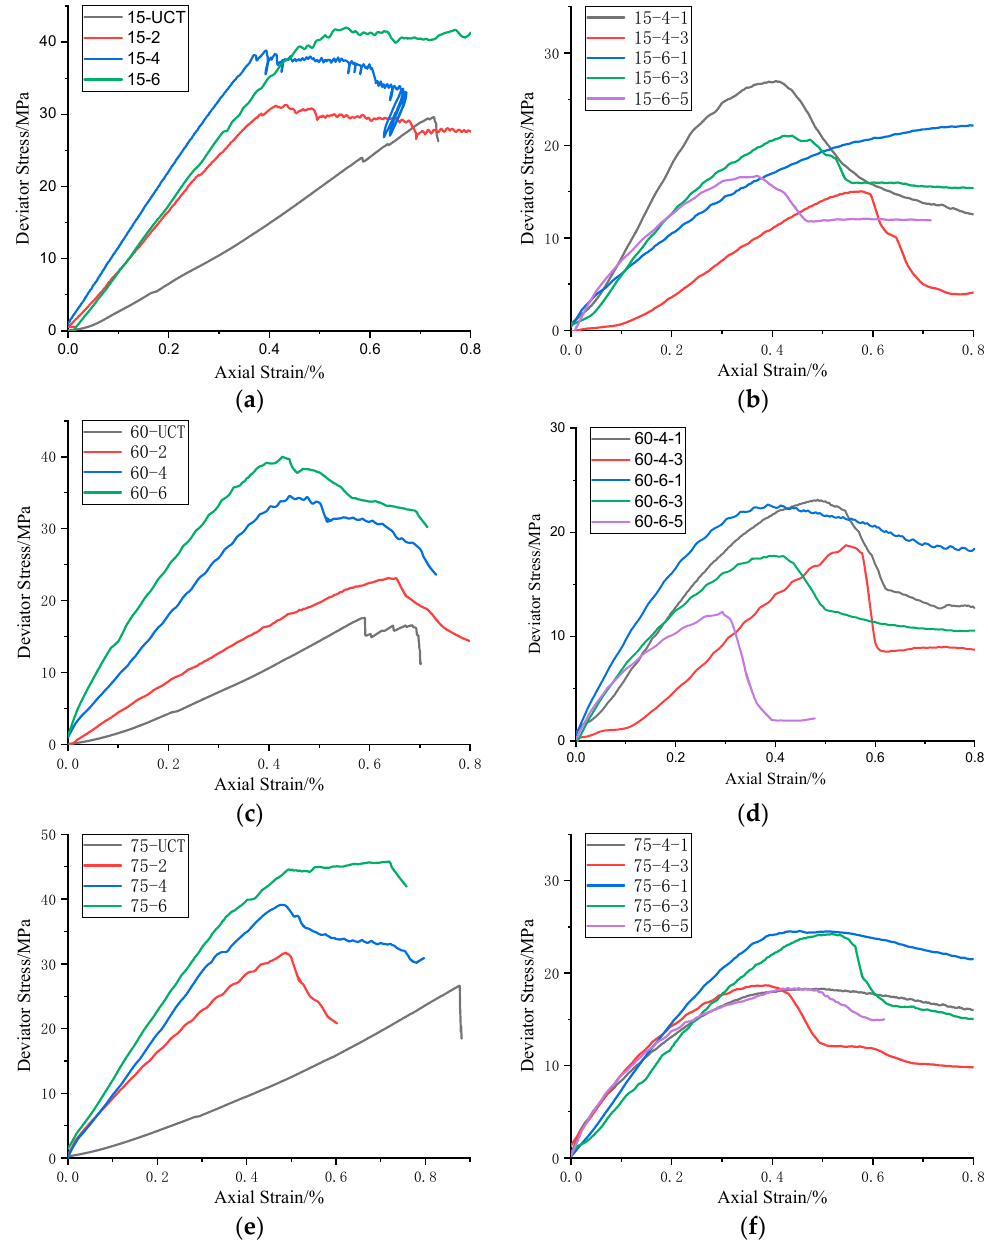
Figure 4. Part of stress–strain curves as an example. ( a ) 15° specimens in uniaxial and triaxial compression tests; ( b ) 15° specimens in hydraulic coupled triaxial tests; ( c ) 60° specimens in uniaxial and triaxial compression tests; ( d ) 60° specimens in hydraulic coupled triaxial tests; ( e ) 75° specimens in uniaxial and triaxial compression tests; ( f ) 75° specimens in hydraulic coupled triaxial tests.